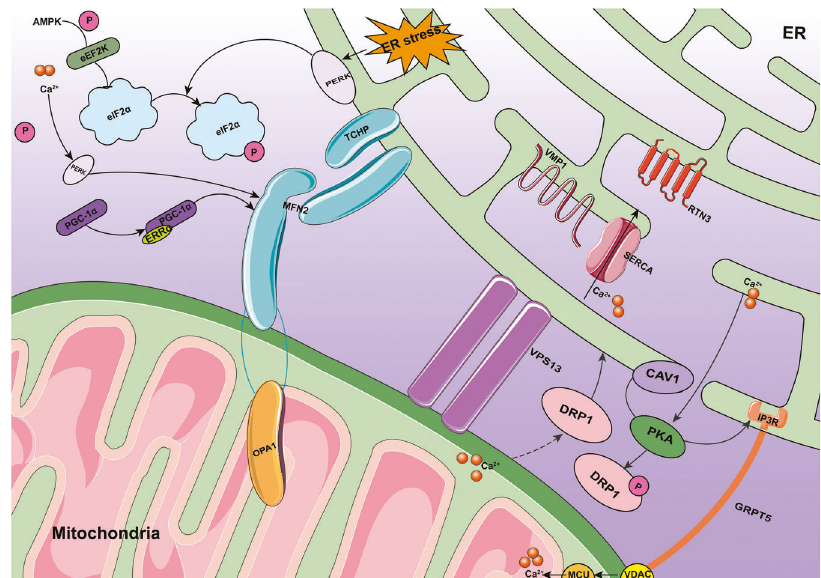
Fig. 1 Crosstalk between the ER and mitochondria. ER-MITO contact provides a platform for crosstalk between these two organelles. Vps13 directly transfers lipids between the ER and mitochondria via hydrophobic channels spanning the entire N-terminal half of its rod. CAV1 acts as a PKA anchoring protein. ER stress and mTORC1 inhibition activate PKA. MTORC1 inhibition leads to PKA-mediated phosphorylation of DRP1 in an inhibitory manner. The IP3R-GRP75-VDAC1-MCU calcium regulatory axis mediates podocyte apoptosis by promoting mitochondrial Ca 2 + overload. VMP1 regulates ER-MITO contact by activating the ER calcium channel, ATP2A/SERCA. TCHP regulates binding between mitochondria and the ER in an MFN2-dependent manner. TCHP expression causes mitochondria to break and relax their binding to the ER. AMPK is an upstream activator of PGC-1 α that increases PGC-1 α expression. eEF2K activity is regulated by AMPK phosphorylation at multiple sites. EEF2K can be inhibited by mTORC1-dependent phosphorylation of three different serine residues. AMPK activates eIF2 α phosphorylation and prevents its